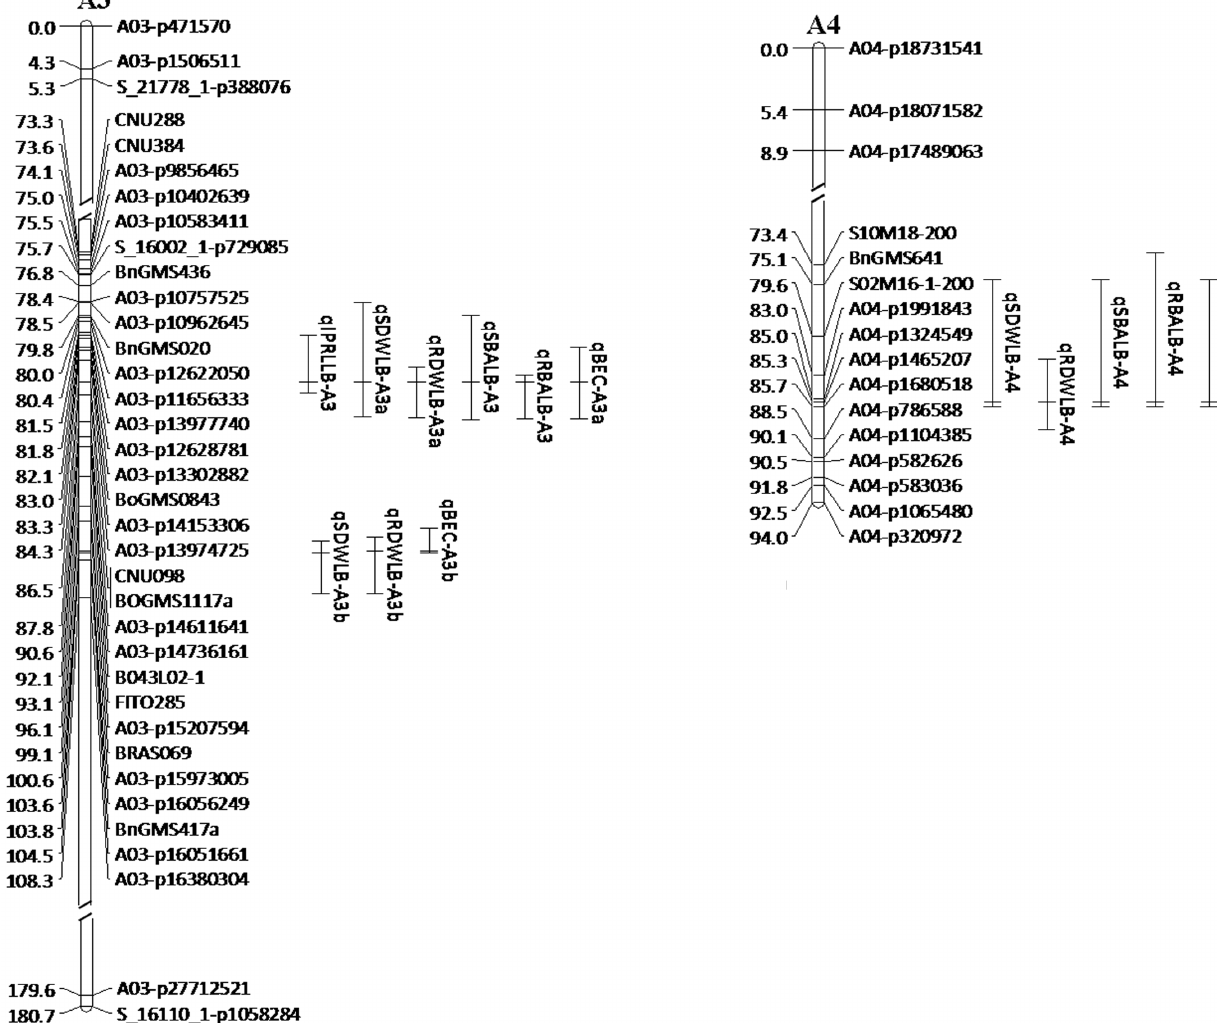
Figure 2. Co-location of QTLs for the B efficiency coefficient (BEC), plant growth and B uptake traits in the QW DH population.